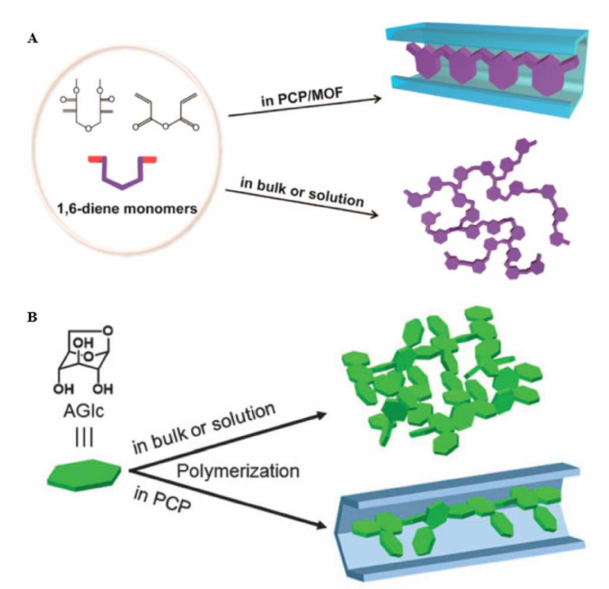
Figure 19. ( A ) Scheme showing the polymerization of 1,6-diene in MOF channel and in bulk or solution. ( B ) Polymerization of AGlc in bulk, solution, and 1D nanochannels of MOFs [102,103]. Copyright 2014, American Chemical